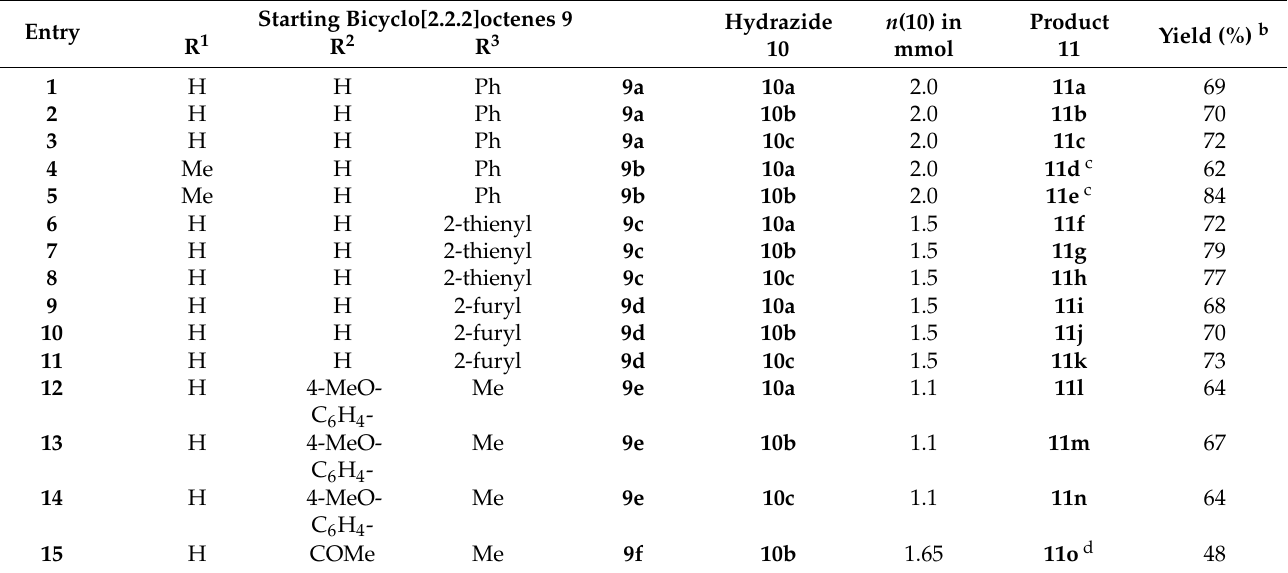
Table 1. Reaction conditions and yields for the synthesis of 11a – o a